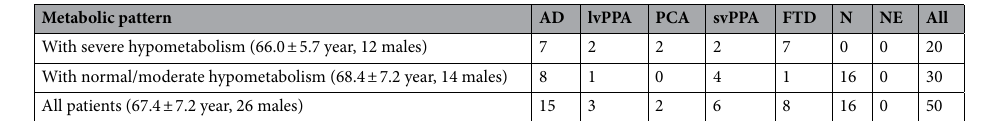
Table 1. Number of patients classified for each metabolic pattern according to consensus based on PET STD : patients were also classified in two categories “severe hypometabolism” and “normal/moderate hypometabolism” according to regional PET STD quantification. N Normal, NE non-evaluable, AD Alzheimer’s disease, lvPPA logogenic variant of progressive primary aphasia, PCA posterior cortical atrophy, svPPA semantic variant of progressive primary aphasia, FTD frontotemporal dementia.